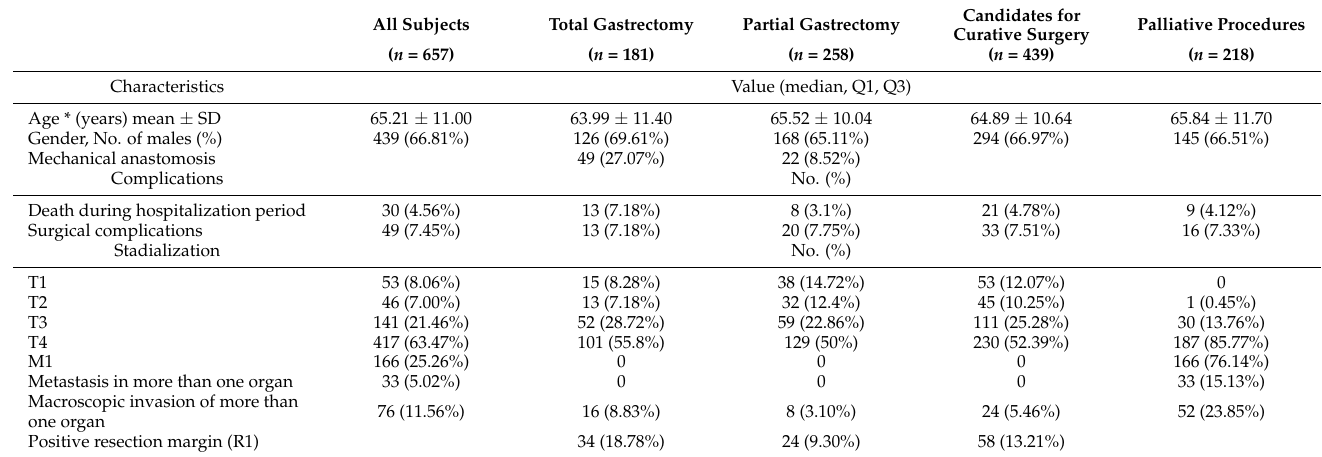
Table 1. The main characteristics of the sample ( n = 657).